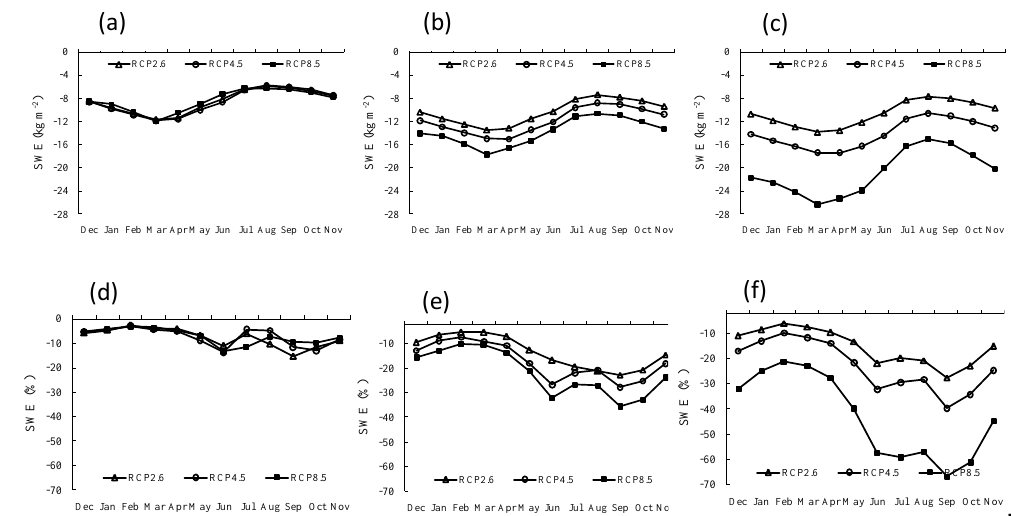
Figure 6. Projected absolute (a–c) and relative change (RC) (d–f) in monthly SWE over Northern Hemisphere land for 2016–2035 (left), 2046–2065 (middle), and 2080–2099 (right).